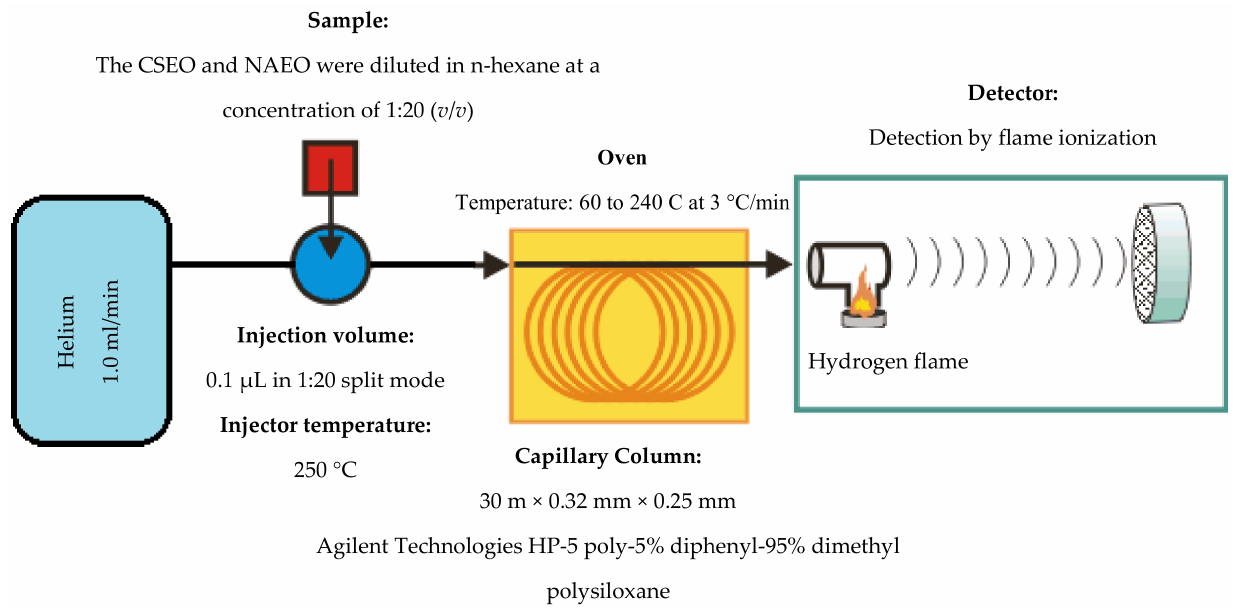
Figure 2. Equipment components and operating conditions of the GC-MS